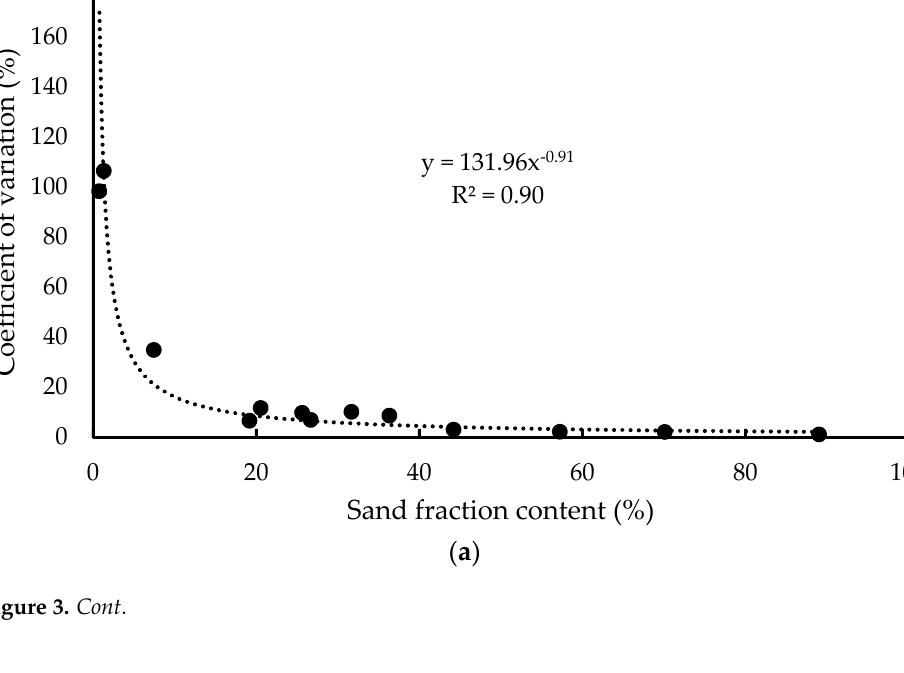
presented in Figure 3.